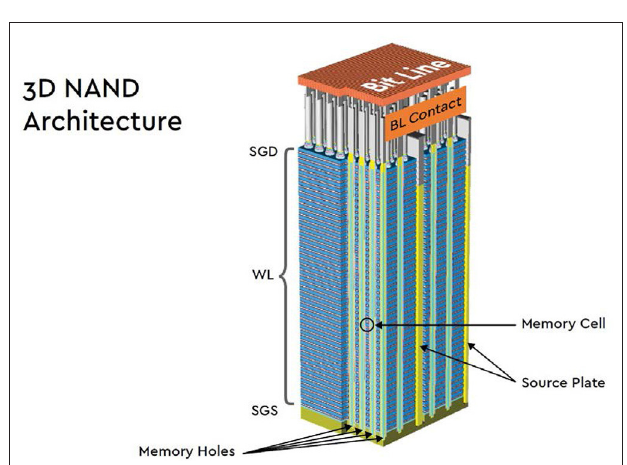
FIGURE 12 | Sketch of a modern 3D NAND FLASH structure architecture from Western Digital [